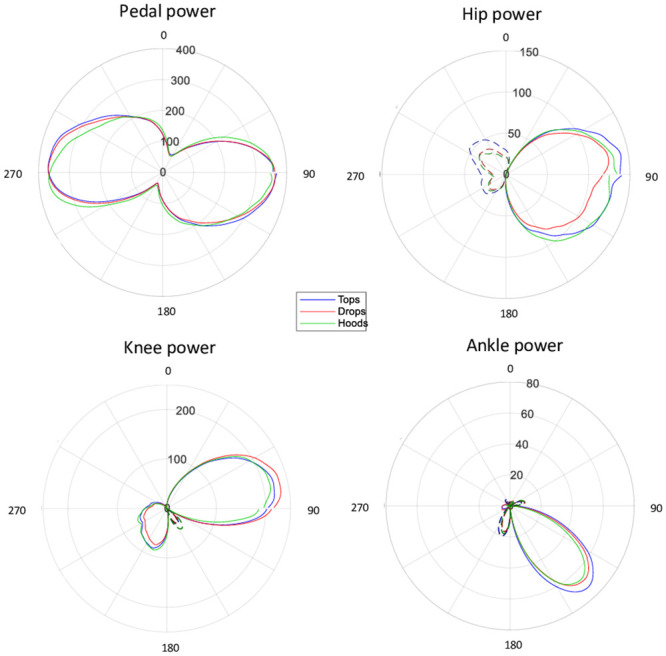
Polar plots for pedal power (W, both legs combined) and hip, knee and ankle joint power (W, one leg only) presented as a function of crank angle for three handgrip positions at 200W for a representative subject.Pedal cycle is clockwise. Labels inside the plots indicate y-levels.